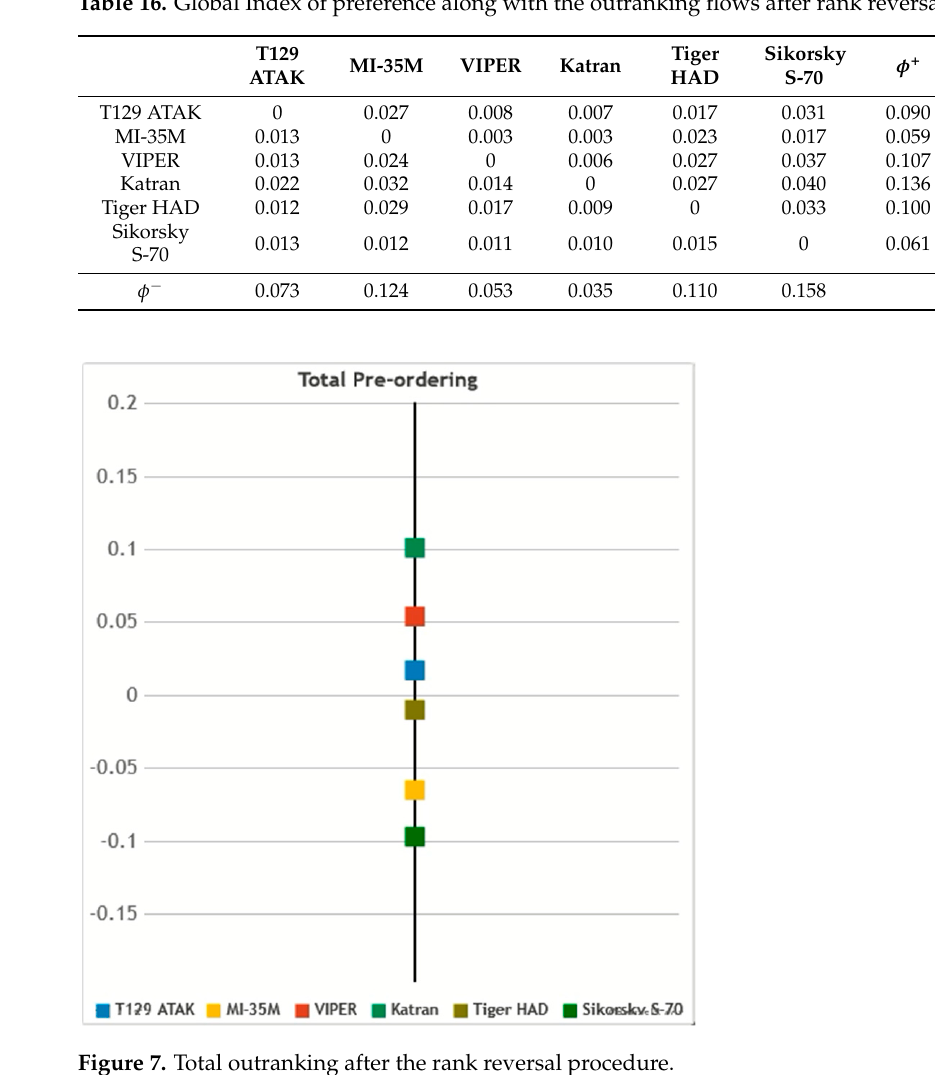
Figure 7. Total outranking after the rank reversal procedure. Based on the new net outranking flows and considering a total preference analysis, it is observed that the outranking relation between alternatives sustained their positions. Regarding this new evaluation, in Figure 7, it is noticeable an approximation between the alternatives T129 ATAK to Tiger HAD and a distance increase relative to alternatives MI-35M and Sikorsky